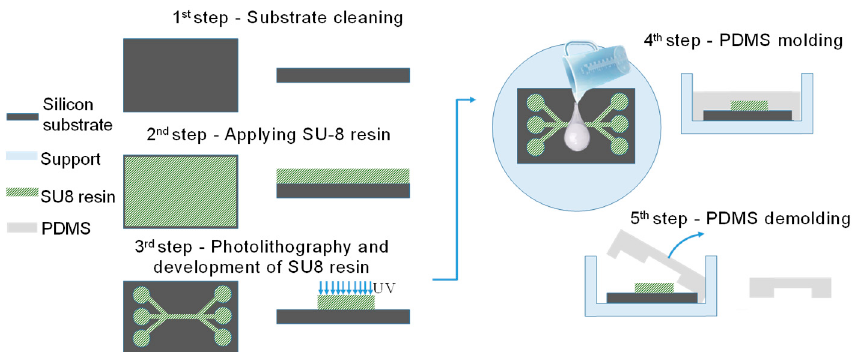
Figure 12. Realization process for the microfluidic part.